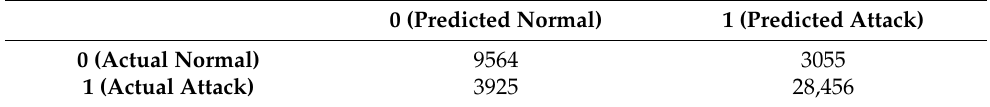
Table 2. Confusion matrix of LM algorithm.